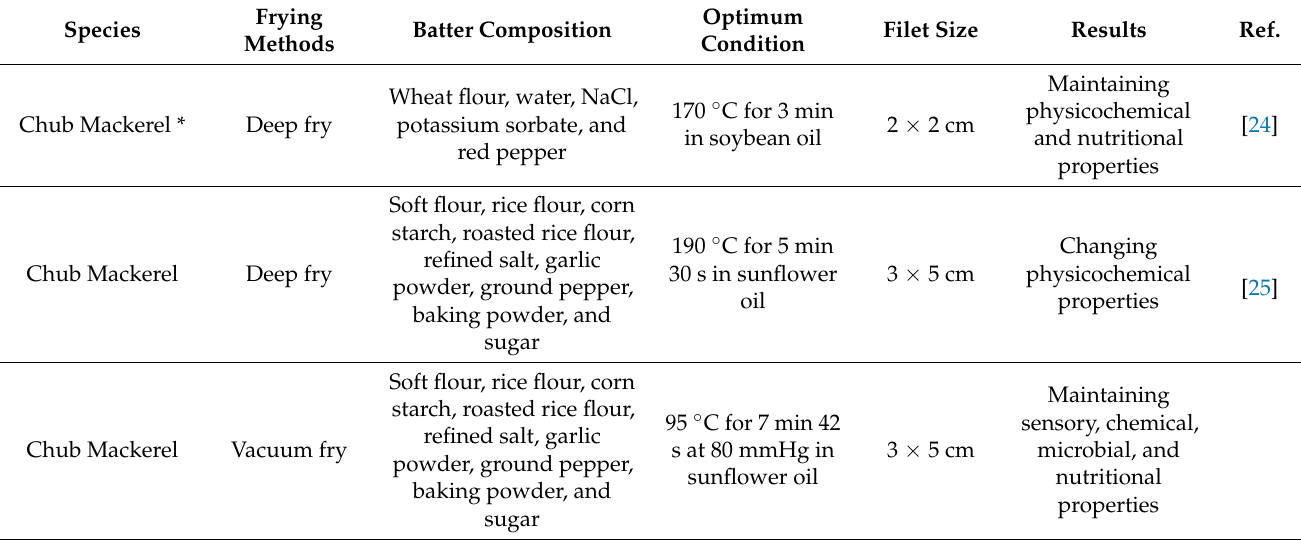
Table 3. Optimum condition for frying mackerel with